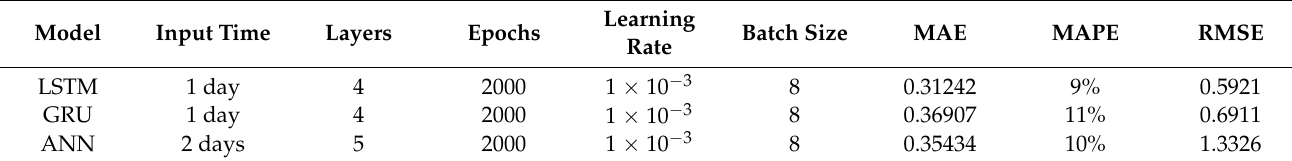
Table 7. The hyperparameter tuning results of hybrid